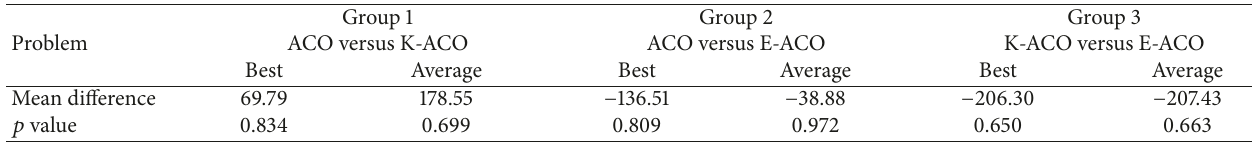
Table 3: 𝑡 -test significance results between each